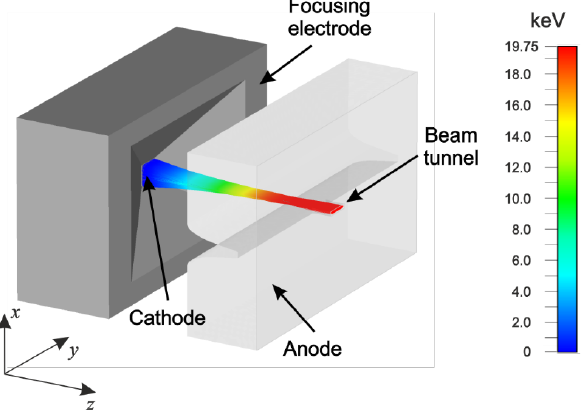
Figure 1. Schematic of the electron gun design.